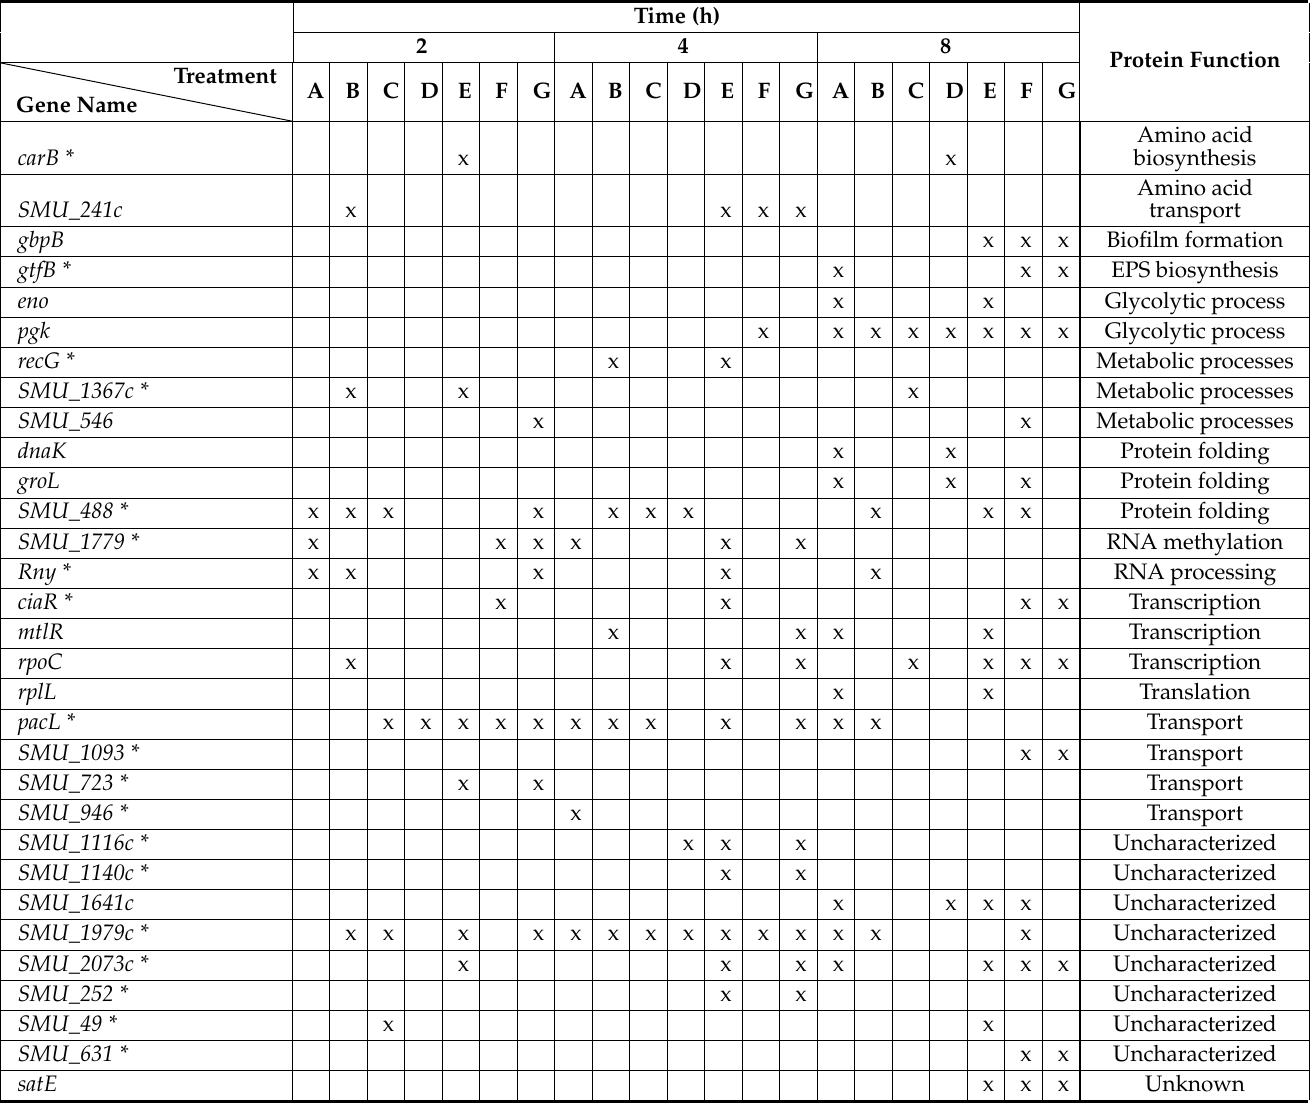
Table 4. Cell wall proteins identified in the adhered S. mutans according to the treatments and time points